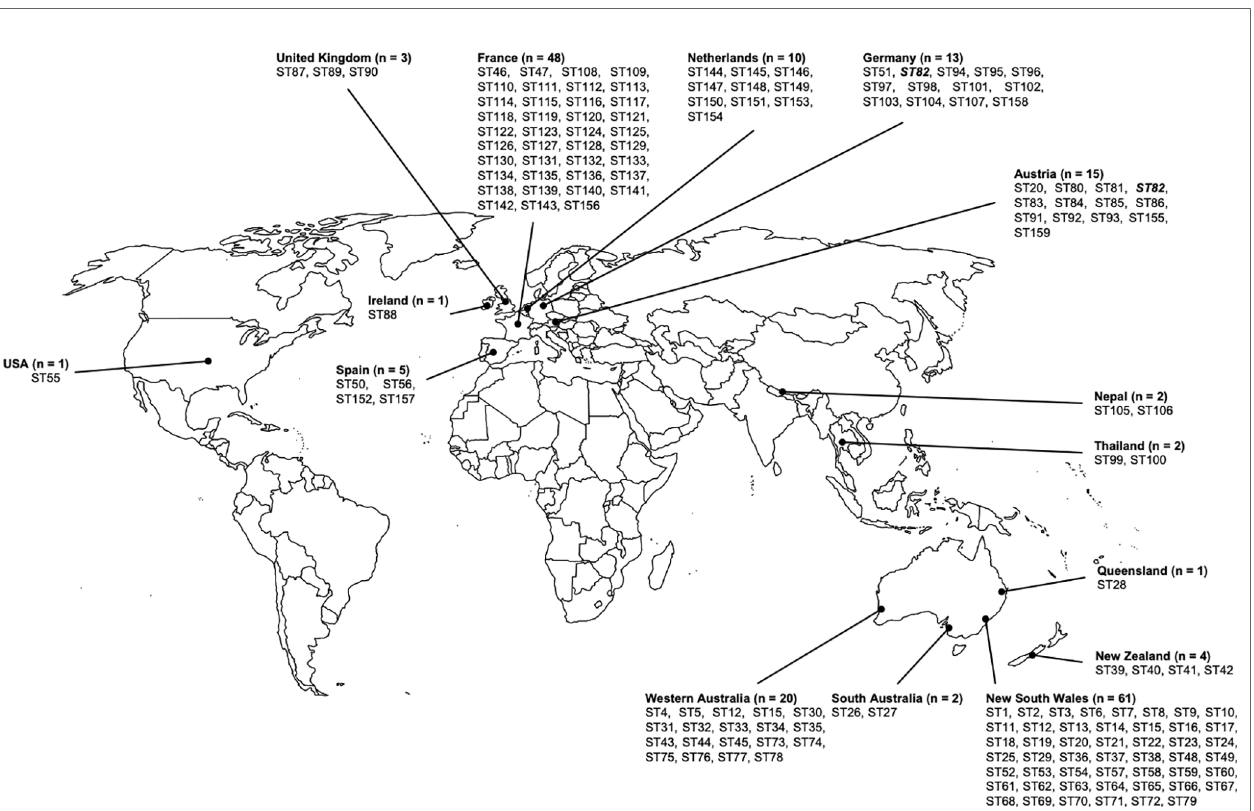
FIGURE 1 | Geographic distribution of Scedoporium aurantiacum isolates. Distribution of studied Scedosporium aurantiacum isolates and their identi fi ed sequence types within Australia, New Zealand, Asia, Europe, and United States. ST's in bold and italics are the only ST shared between two